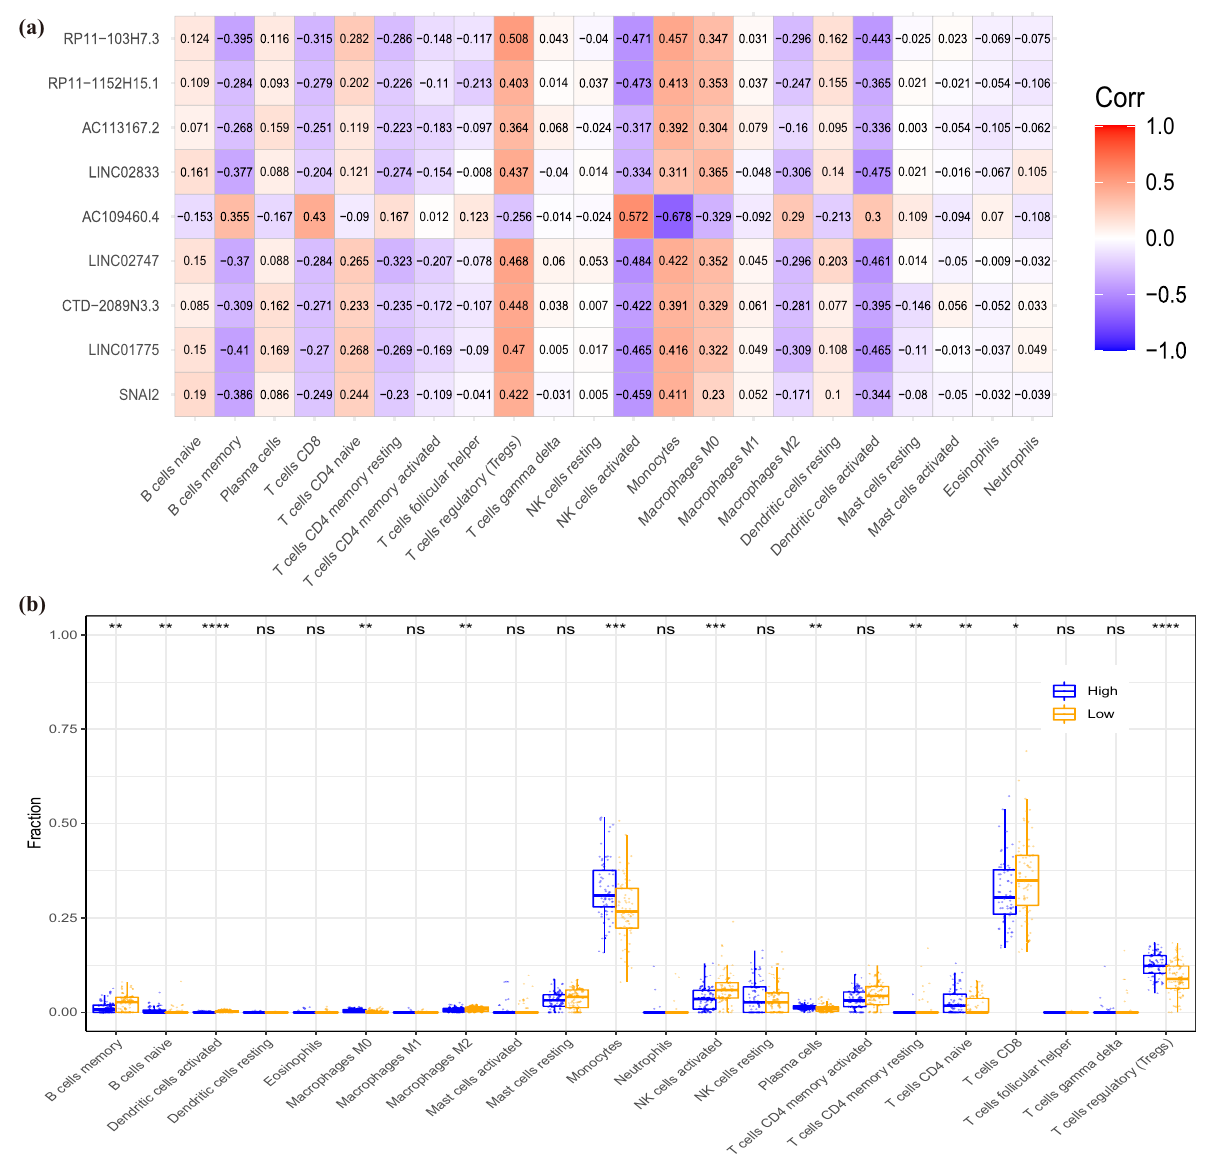
Figure 7: Immune analysis of SNAI2. ( a ) Pearson correlation heatmap between eight EMT - related diagnostic signatures and in fi ltrating immune cells. ( b ) Boxplot comparing immune cell compositions between high SNAI2 expression level groups and low SNAI2 expression level